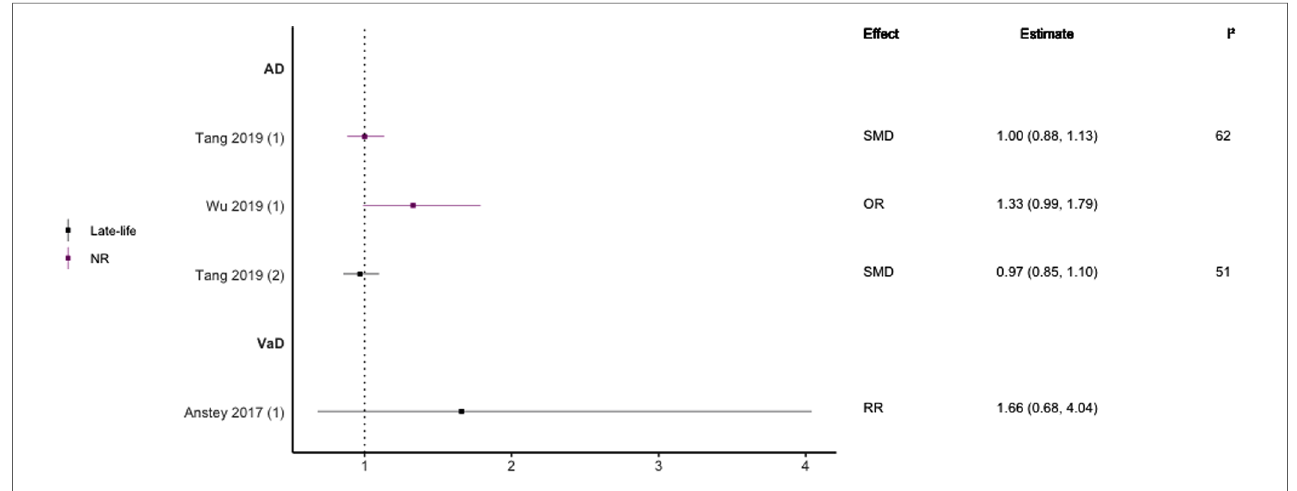
FIGURE 10 Effect estimates of meta-analyses reporting an association between TG and dementia. The vertical line represents no effect, with different colours conveying age. Note, SMDs have been converted to approximate ORs using OR ¼ exp mean difference; VaD, vascular